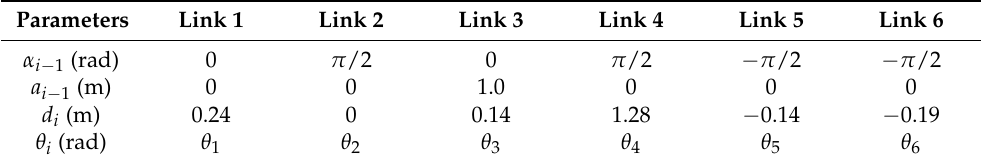
Table 3. The link parameters of the